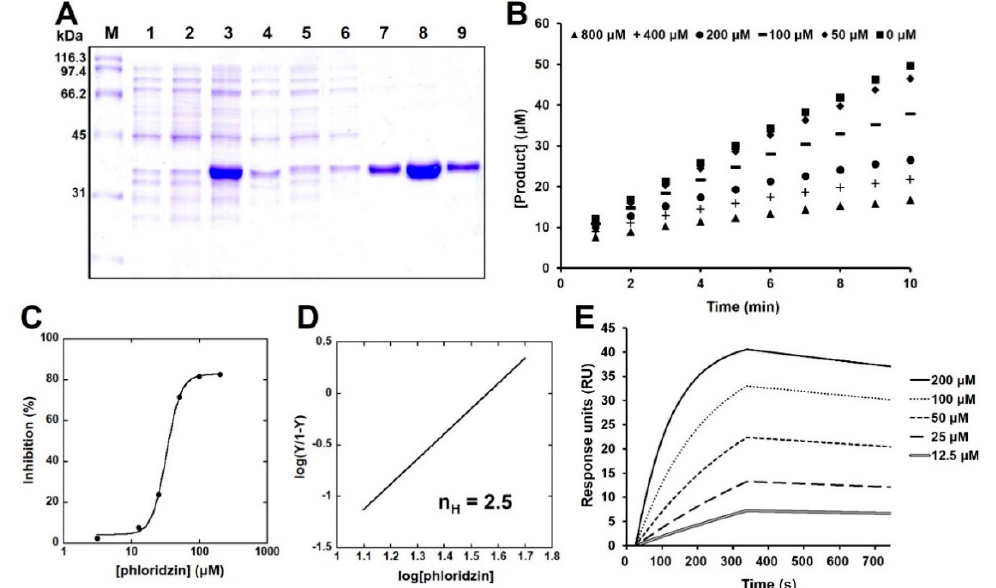
Figure 3. PTP-MEG2 inhibition by phloridzin. ( A ) Polyacrylamide gel electrophoresis (PAGE) anal-